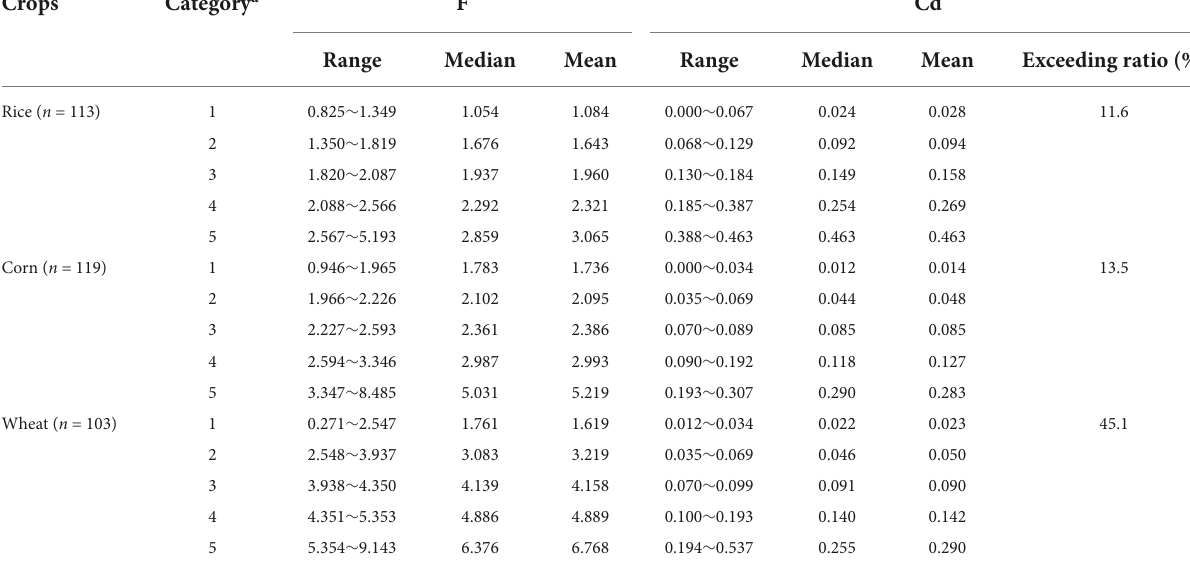
TABLE 1 The contents of F and Cd in rice, corn, and wheat grains (mg/kg). Crops